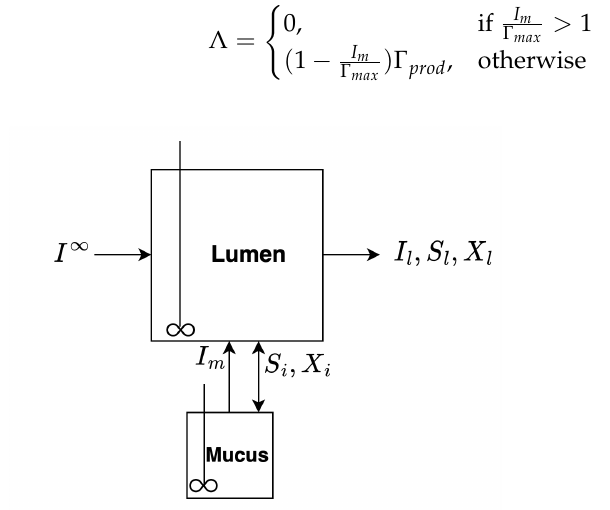
Figure 2. The reactor representation of the dual compartment model. Both compartments are fully mixed. For the lumen compartment, there is inflow of fiber ( I ∞ ) and outflow of fiber ( I l ), sugar ( S l ) and biomass ( X l ). There is transport of sugar ( S i ) and biomass ( X i ) between the lumen and mucus compartments, where i ∈ { l , m } . There is no transport of fiber ( I l ) between compartments. Transport of mucin ( I m ) is unidirectional from the mucus to the